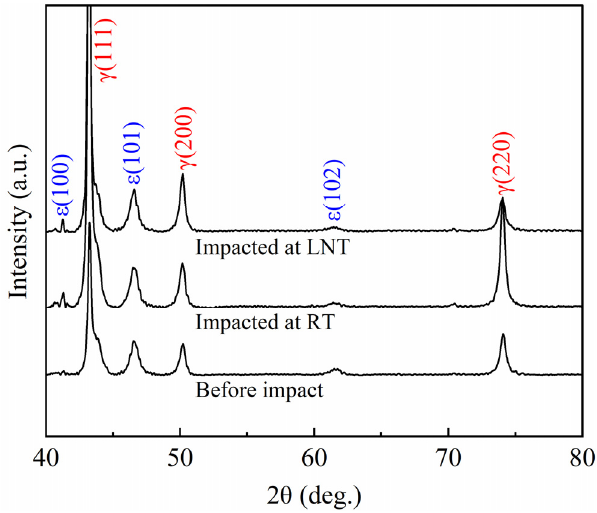
Figure 10. X-ray diffraction patterns of A1000 specimen before and after RT and LNT impact tests.